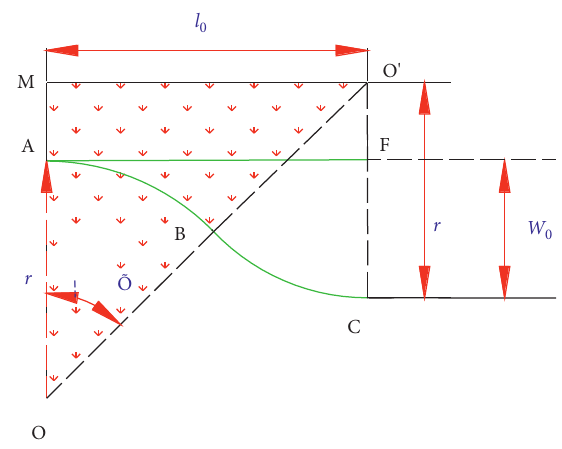
Figure 3: Geometrical relationship of